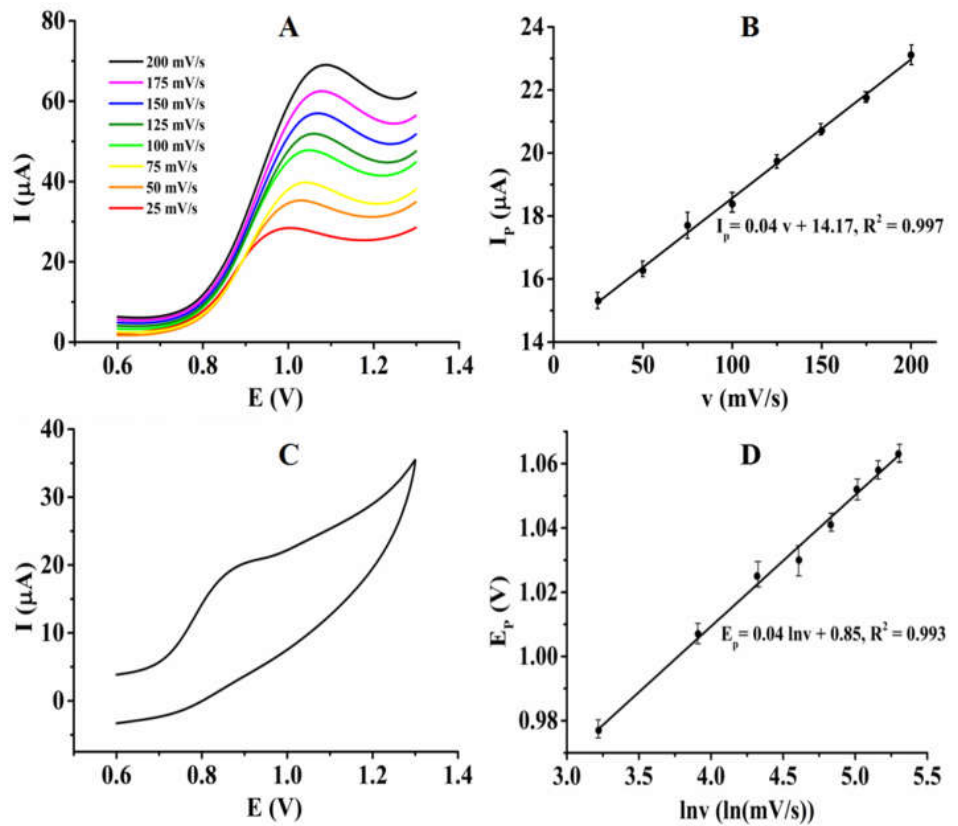
Figure 8. ( A ) Linear sweep voltammograms of PTP–AgNP/PGE in 0.1 M phosphate buffer solution (pH = 4.0) containing 2 mM NO 2 − at different scan rates. ( B ) Linear relationship of the oxidation peak currents of NO 2 − (I p ) with scan rates. ( C ) Cyclic voltammogram of 2 mM NO 2 − on PTP–AgNP/PGE in 0.1 M PB (pH = 4.0). ( D ) Linear relationship of the oxidation peak potentials of NO 2− (E p ) with the natural logarithm of scan rates.